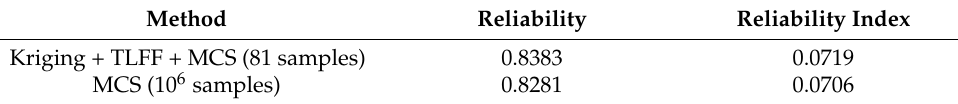
Table 5. Results for the ignition reliability of the pyrotechnic igniter.